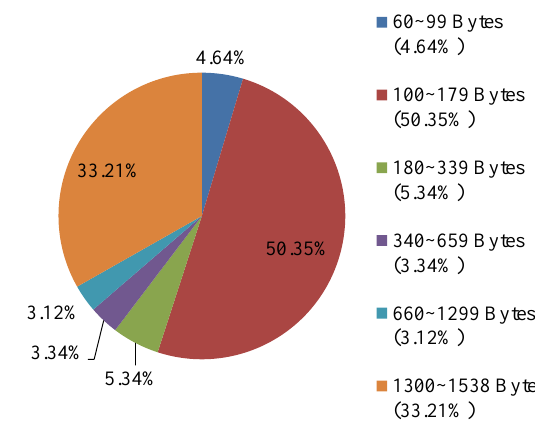
Figure 14. Distribution of Ethernet packets.